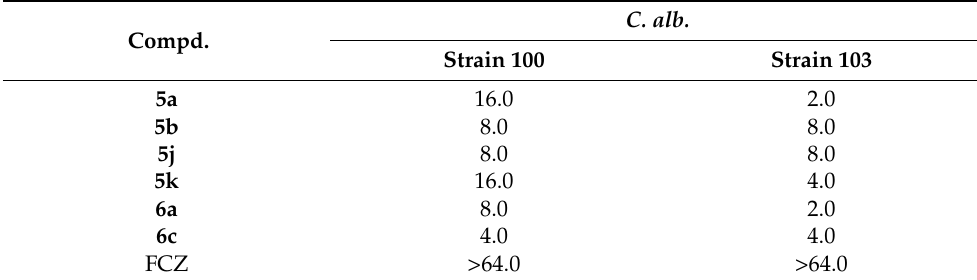
Table 2. In vitro antifungal activity of the target compounds (MIC, µ g/mL). Compd.